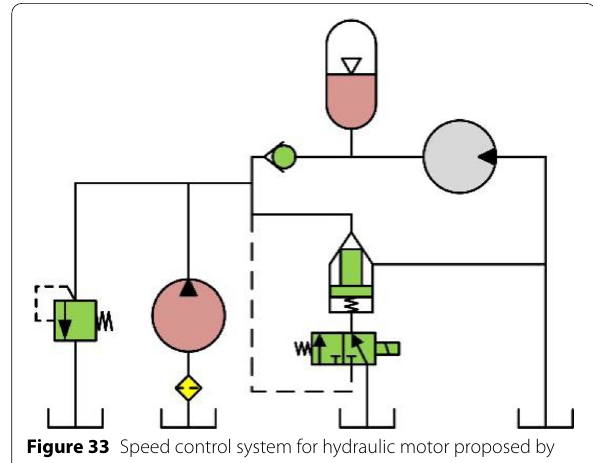
Figure 33 Speed control system for hydraulic motor proposed by Qiu et